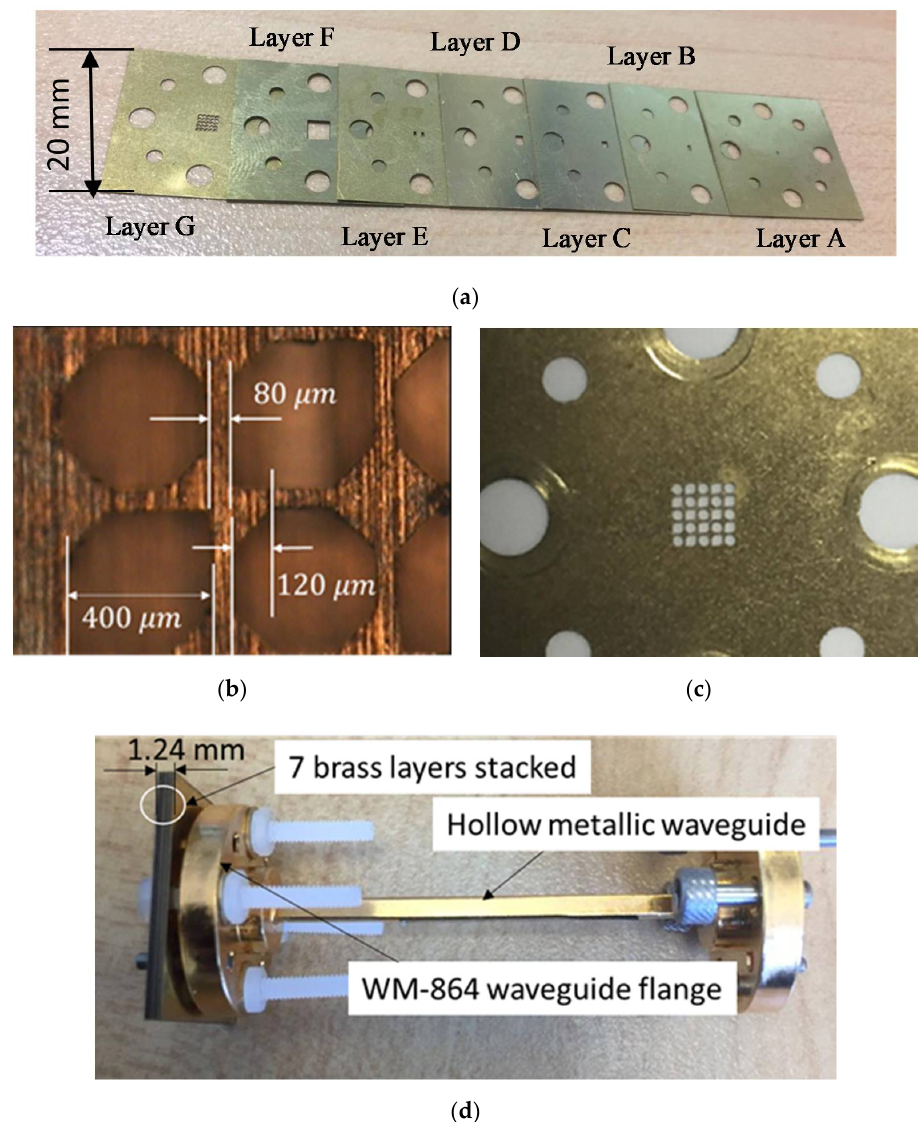
Figure 2. Photographs of manufactured CP-RCA at 300 GHz ( a ) seven metal brass fabricated layers; ( b ) microscopic image of MTS layer; ( c ) enlarged image of CP-MTS layer; and ( d ) fabricated prototype connected to standard UG−387/U waveguide flange [25].